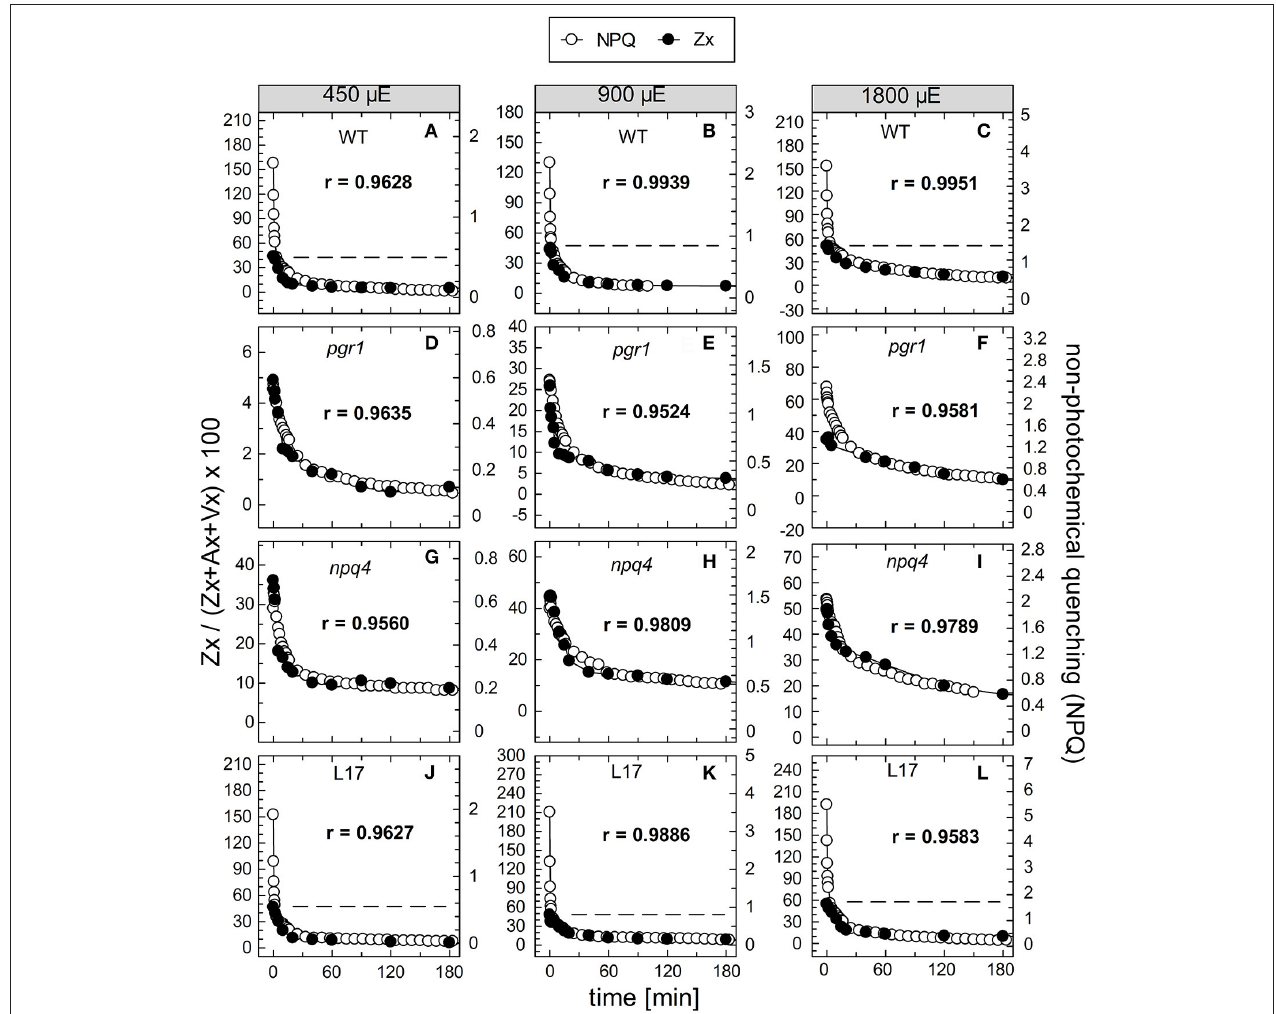
FIGURE 9 | Comparison of the kinetics of NPQ relaxation and Zx epoxidation after 90min of pre-illumination . The data for NPQ relaxation (open circles) and Zx epoxidation (filled circles) after 90min of pre-illumination at the three actinic light intensities of 450, 900, and 1,800 µ E are compared for the four genotypes with an active xanthophyll cycle: (A–C) WT, (D–F) pgr1 , (G–I) npq4 and (J–L) L17 . For direct comparison, the data for Zx epoxidation were fitted to match the amplitudes of the slowly relaxing ( > 2min) NPQ components, only. The data were taken from Figure 6 (NPQ) and Figure 7 (Zx). The dotted lines in panels (A–C) and (J–L)